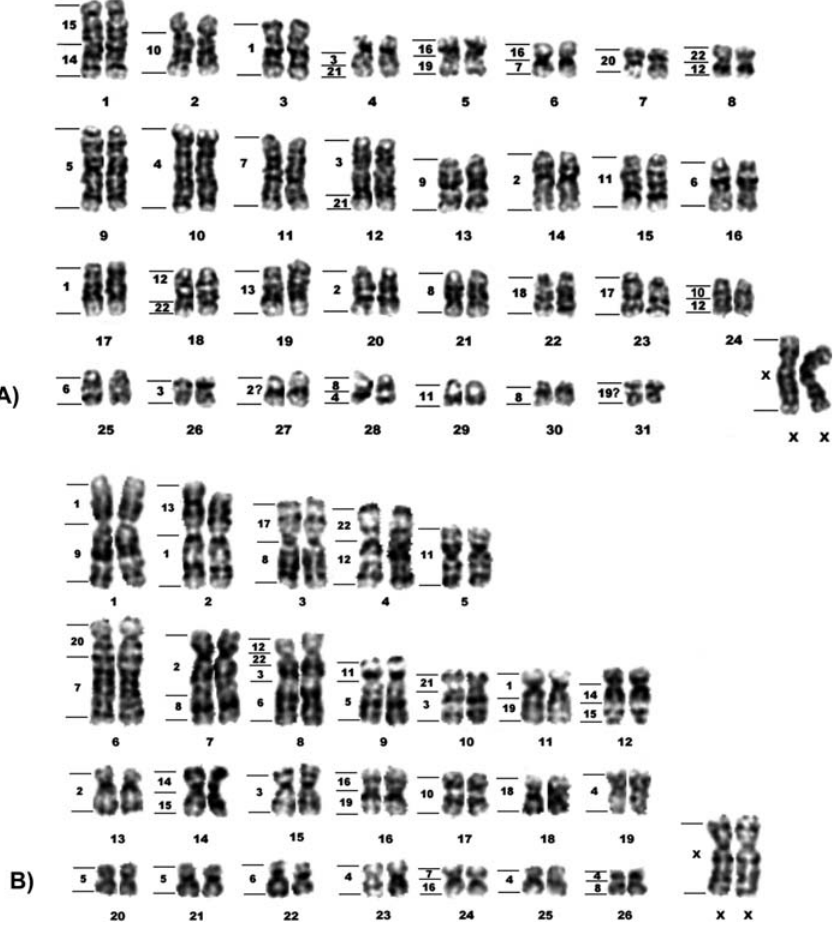
Figure 2. G-Banded Karyotypes of Female Nine-Banded Armadillo and Female Lesser Anteater (A) Female nine-banded armadillo D. novemcinctus (2 n ¼ 64) and (B) female lesser anteater T. tetradactyla (2 n ¼ 54). The correspondence to human chromosomes as revealed by chromosome painting is shown on the left of each chromosome. The question mark indicates questionable results. Some regions were not painted by any human probe and are probably composed of repetitive sequences (see text). DOI: 10.1371/journal.pgen.0020109.g002